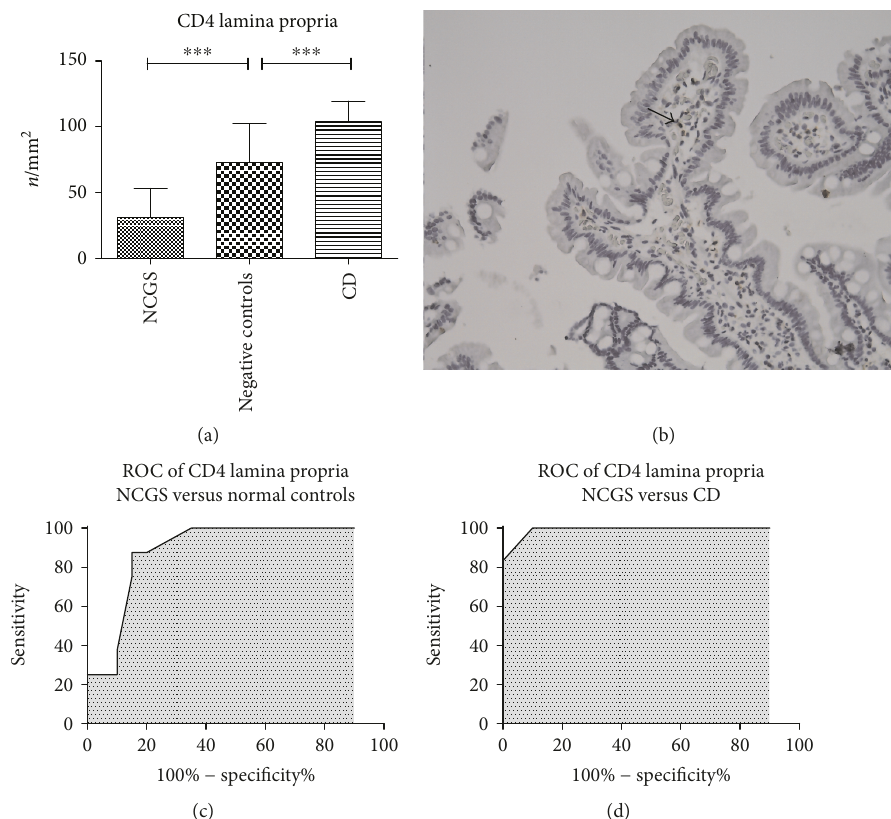
Figure 2: Immunohistochemical expression of CD4 in lamina propria (a). Bars and error bars represent mean and standard deviation, respectively. ∗∗∗ p < 0 001 . (b) An immunohistochemical picture of a patient with NCGS: positive cells are stained in brown, magni fi cation × 200. (c and d) ROC curves of sensitivity analysis of CD4 count as a discriminative factor between NCGS and celiac disease or normal controls. An arrow highlights positive